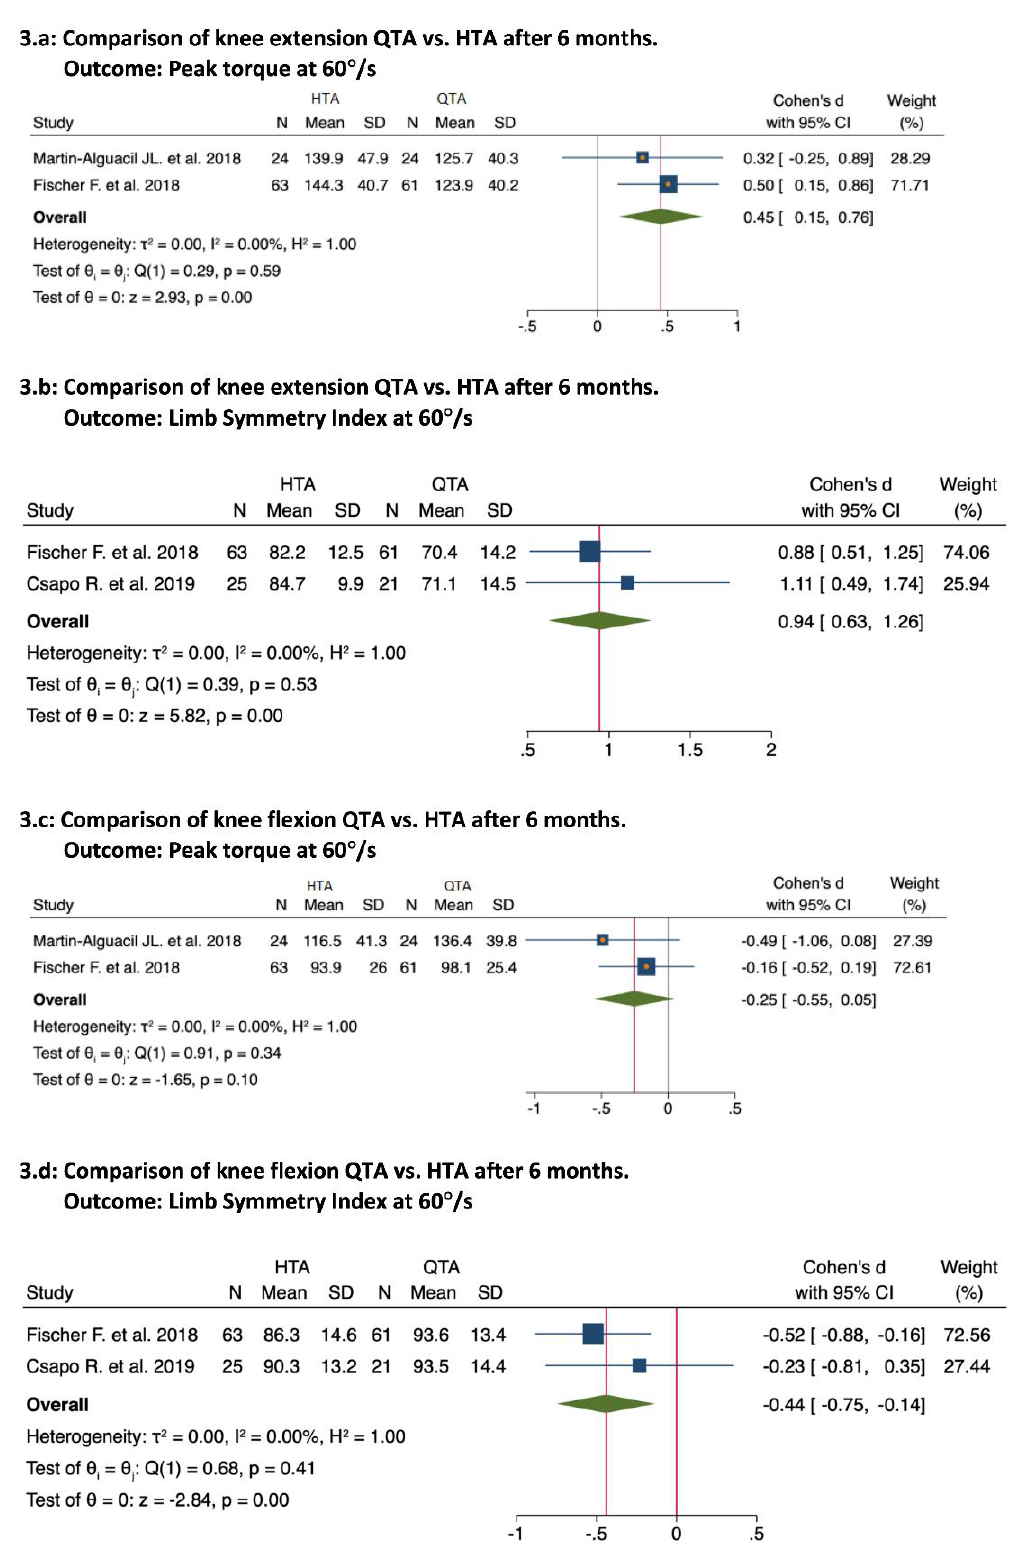
Figure 3. Forest plots for knee isokinetic strength test at 60°/s at 6 months [41,42,44].